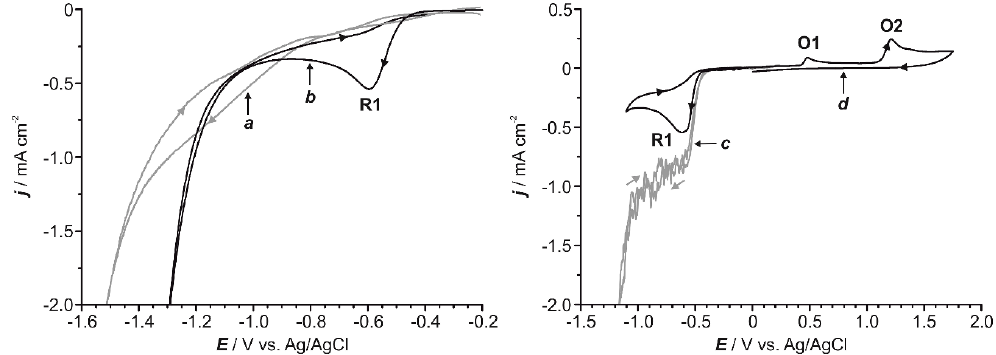
Figure 1. Cyclic voltammograms for a 0.6 mM aqueous solution of 4-NP (0.1 M Na 2 SO 4 ) at pH = 5.3 ( a ) and 2.0 ( b ) under stagnant conditions. Cyclic voltammetry for a 0.6 mM aqueous solution of 4-NP (0.1 M Na 2 SO 4 ) at pH = 2.0 under argon-flow agitation ( c ) and global scan, started towards negative